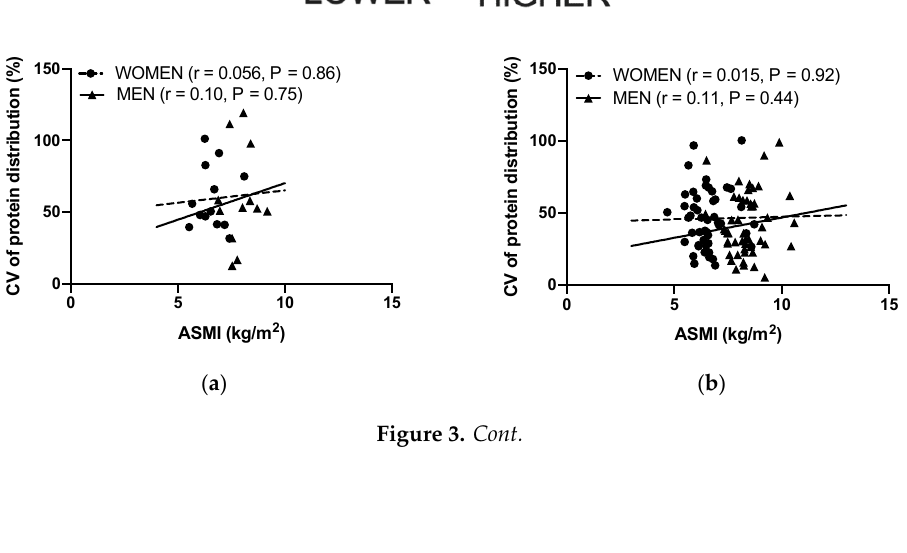
MEN (r = 0.10, P = 0.75) MEN (r = 0.11, P = Figure 3.